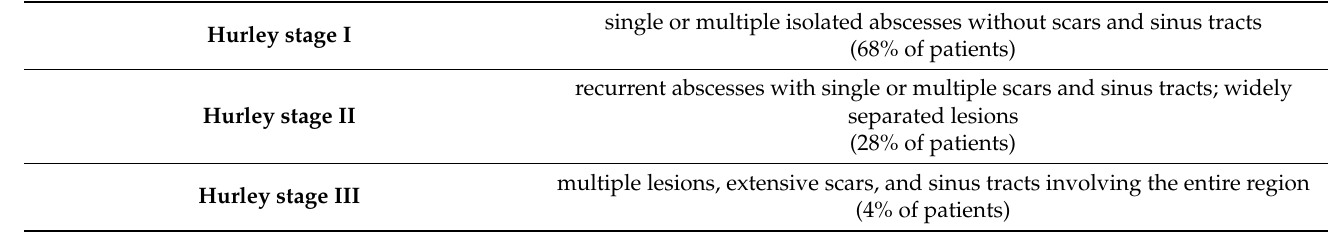
Table 1. Hurley staging system [9].